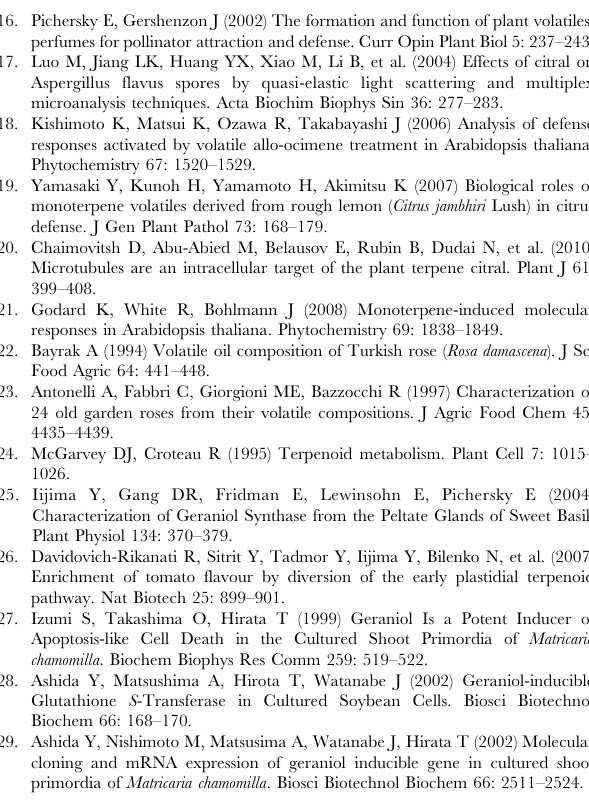
Figure S1 Effect of citral, geranyl acetate and b - citronellol treatment on seedling vigor of wild type tomato Pusa Ruby. Figure S2 Effect of gerainol treatment on seedling vigor of wild type tomato Ailsa Craig (A) and Never Ripe ( Nr )